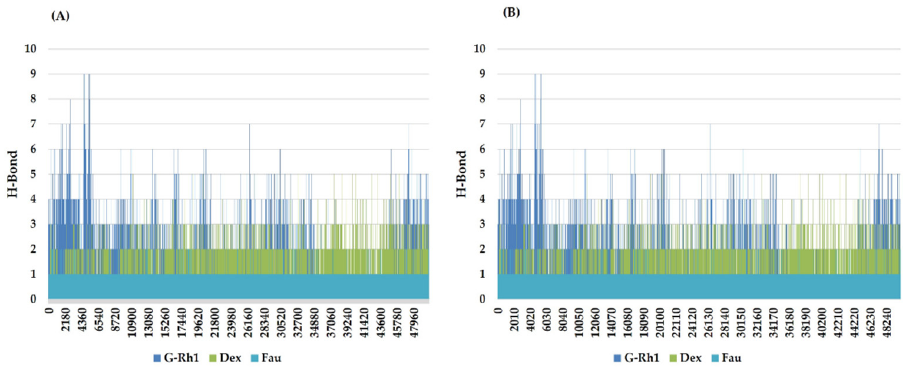
Figure 7. Line plots of Ligand-protein H bonds for ( A ) ROCK1 and ( B ) RhoA with Ginsenosides Rh1 and control (Dexamethasone, Fausidil).